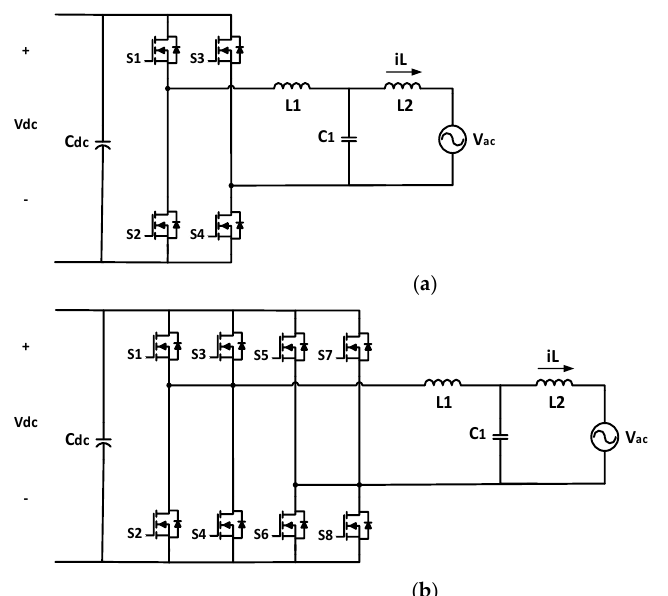
[41]. However, this topology does not address the issue of capacitive leakage current and associated CMV.